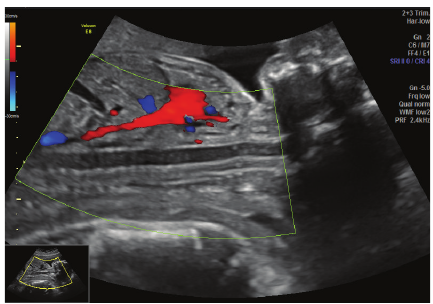
Figure 2: Color Doppler showing absence of flow through the notochord.